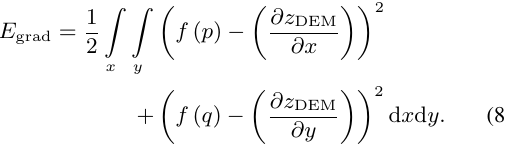
Figure 1: Study area on 67P/Churyumov-Gerasimenko. (a) Regional map of 67P/Churyumov-Gerasimenko. URL: ‹ http://www.esa.int/spaceinimages/Images/2015/ 01/Getting_to_know_Rosetta_s_comet_region_maps ›. Image credit: ESA/Rosetta/MPS for OSIRIS Team MPS/UPD/- LAM/IAA/SSO/INTA/UPM/DASP/IDA. (b) The target image of BAM and SIAM. All images are matched with respect to this image. The red rectangle marks the region of interest, which is refined using SfS. (c) The second image of the stereo